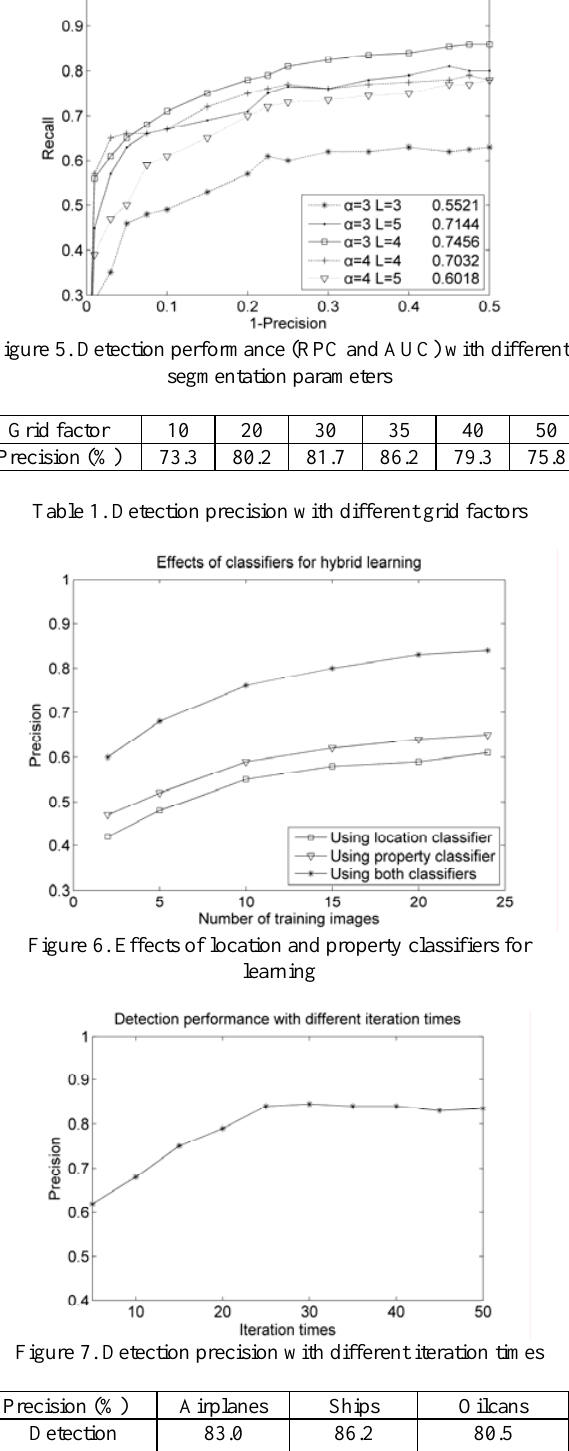
Table 2. Average precision of detection, recognition and segmentation error on image dataset using optimal